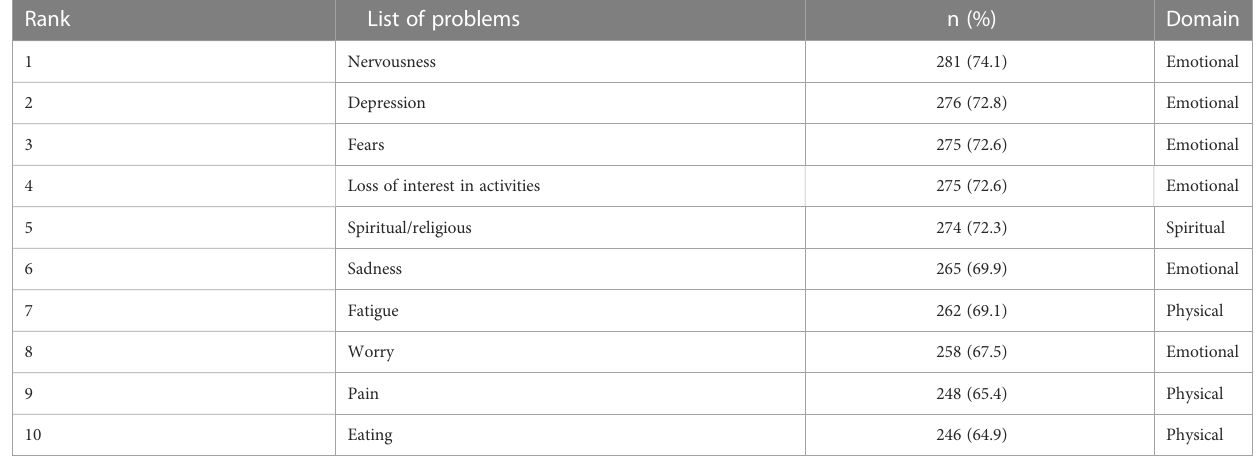
TABLE 4 Top 10 frequent problem list items checked as a source of distress among study participants.